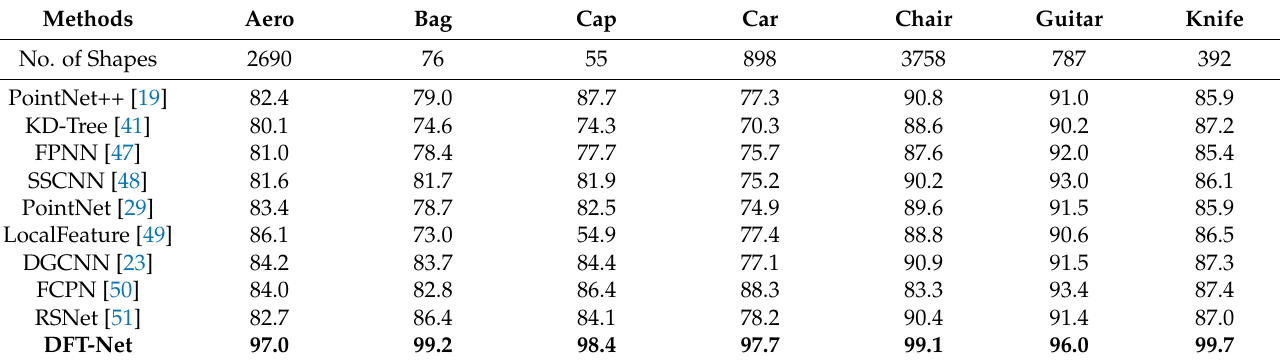
Table 4. Results of Part Segmentation on ShapeNet part